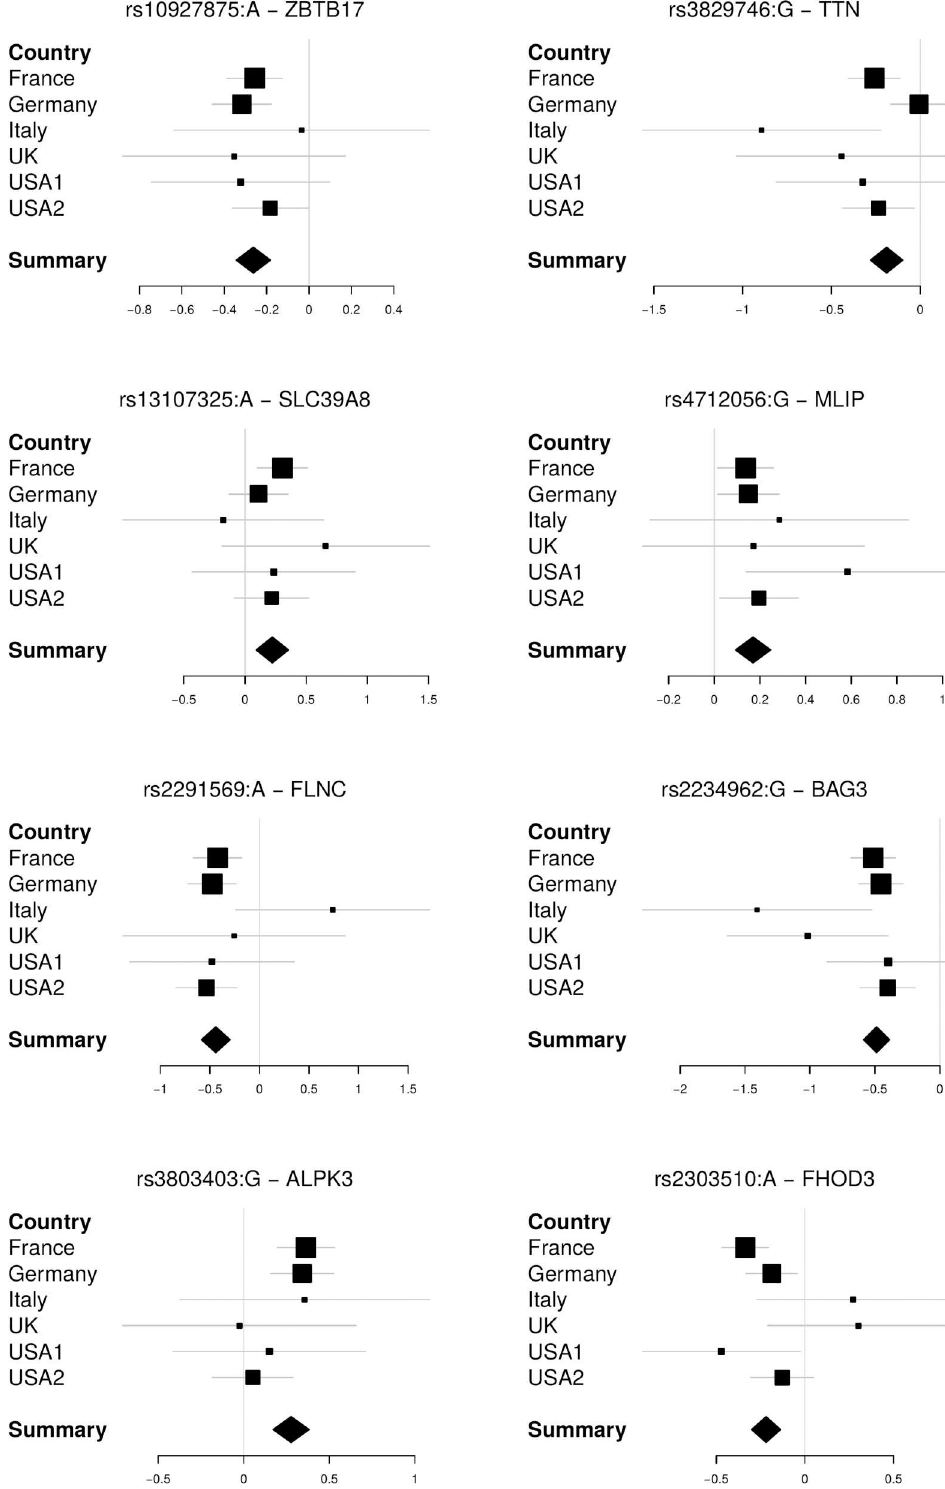
Fig 2. Forest Plots of odd-ratios (log) in the different populations. The results show that the associations were largely homogeneous across populations(See also heterogeneity column in Table 2)